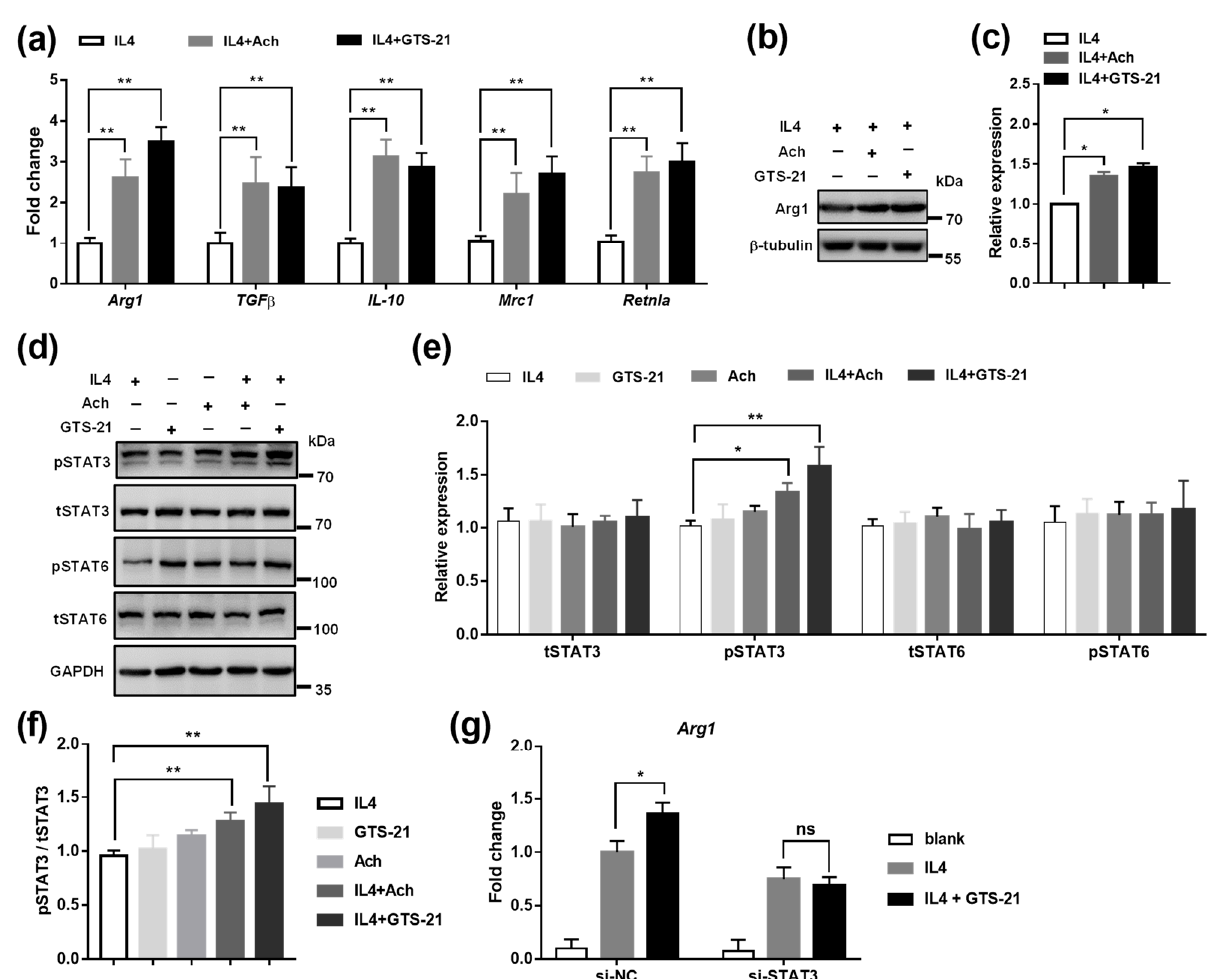
Figure 4. Effects of CAP agonists on M2 macrophage polarization. ( a ) The mRNA expression of M2 type marker genes (i.e., Arg1 , TGF β , IL-10 , Mrc1 , and Retnla ) were upregulated by the treatment of Ach and GTS-21. Data are presented as means ± SD ( n = 3 biological replicates). ** p < 0.01 as compared to IL4 induced cells. ( b , c ) Representative immunoblot images ( b ) and relative quantification ( c ) of Arg1 protein level in IL4-induced BMDM. Data are presented as means ± SD ( n = 3 biological replicates). * p < 0.05 as compared to IL4 induced cells. ( d , e ) Representative immunoblot images ( d ) and relative quantification ( e , f ) of pSTAT3/tSTAT3, tSTAT3, pSTAT3, tSTAT6, and pSTAT6 in response to Ach and GTS-21 treatment in IL4 induced BMDM. Data are presented as means ± SD ( n = 3 biological replicates). * p < 0.05, ** p < 0.01 as compared to blank cells. ( g ) siRNA interference of STAT3 inhibited GTS-21-induced expression of Arg1. Data are presented as means ± SD ( n = 3 biological replicates). * p < 0.05, ns indicates not significant.